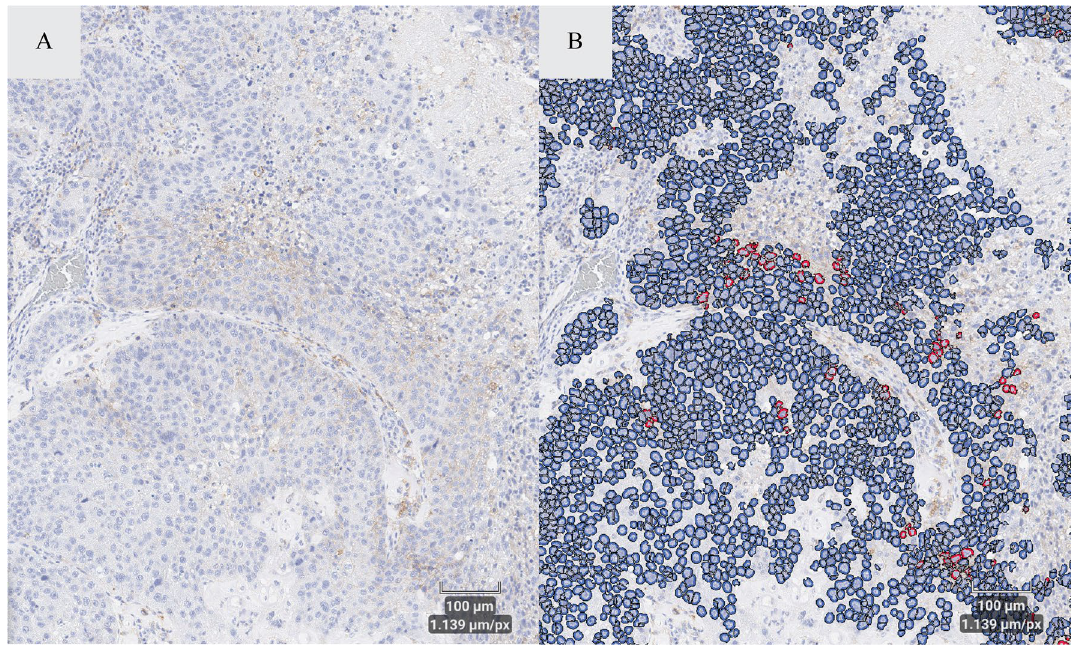
Figure 4. IA algorithm for identifying PD-L1 positive cells in tissue samples. Panel ( A ) shows a field of view of the unmarked PD-L1 stained slide. Panel ( B ) shows the same field of view with labeling of tumor cells in blue (PD-L1 negative tumor cells) and red (PD-L1 positive cells).